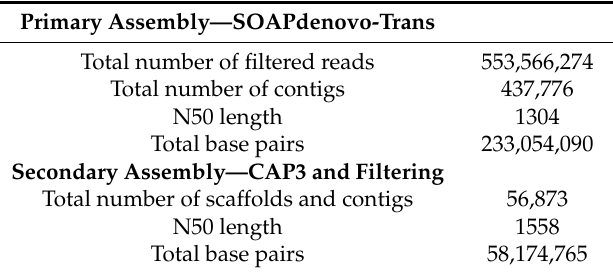
Table 1. Overview of sequencing outputs and